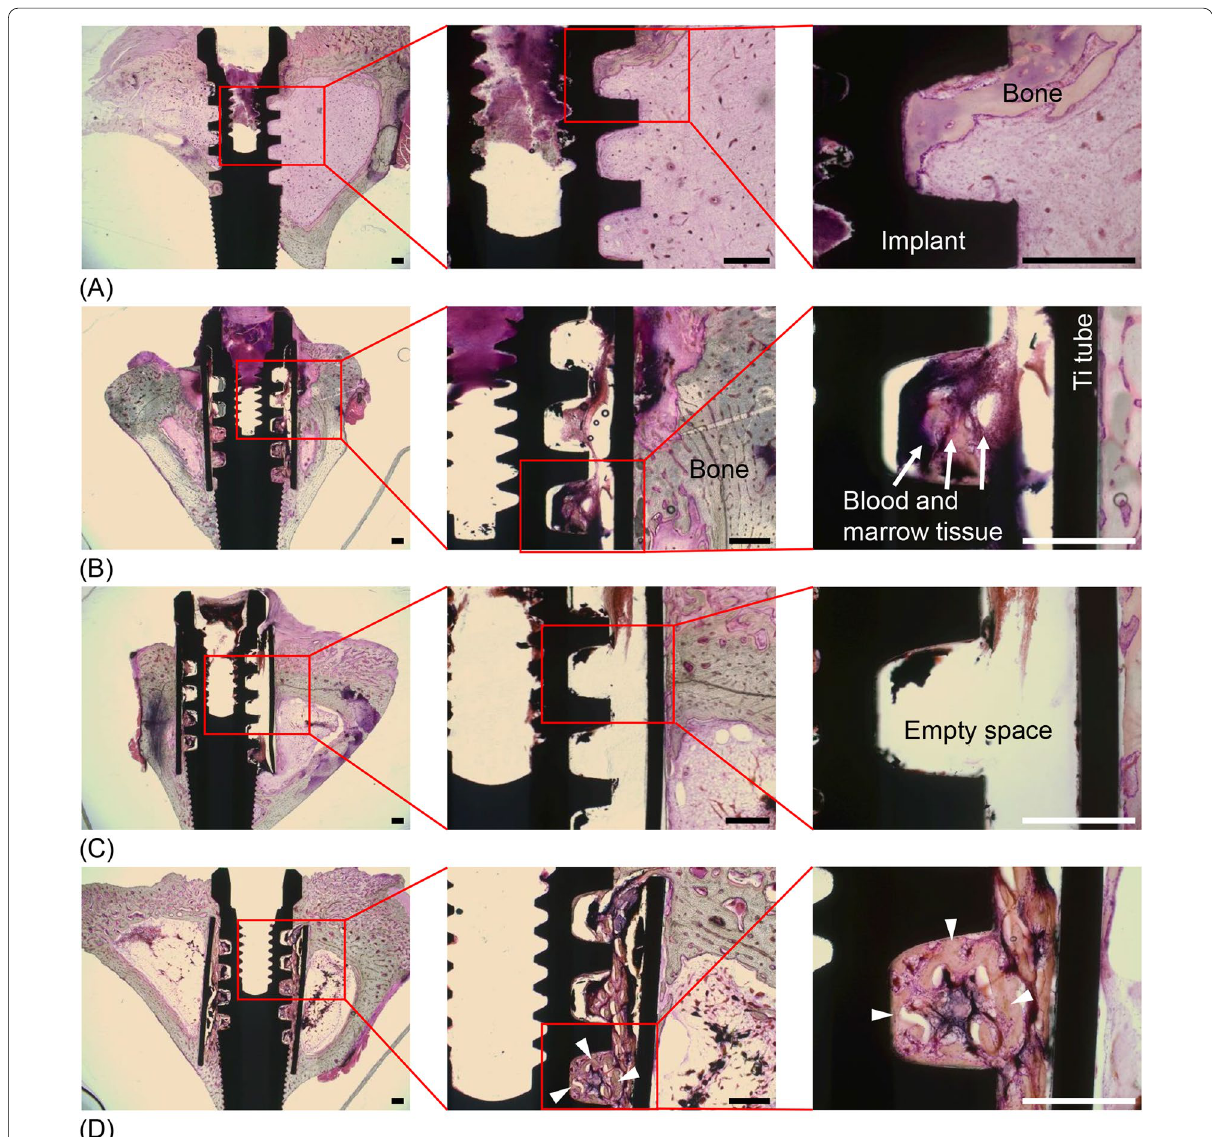
Fig. 5 Representative histological images (haematoxylin and eosin staining) of bone formation in the experiment to evaluate the influence of substances from blood and bone. A In the implant‑only group, normal bone formation was observed around the SLA Ti implants. B In the Ti tube implant group, there were many areas between the implant threads with no bone formation. C In the Ti tube + bone formation was observed between many of the implant threads despite the PRP injection. D In the Ti